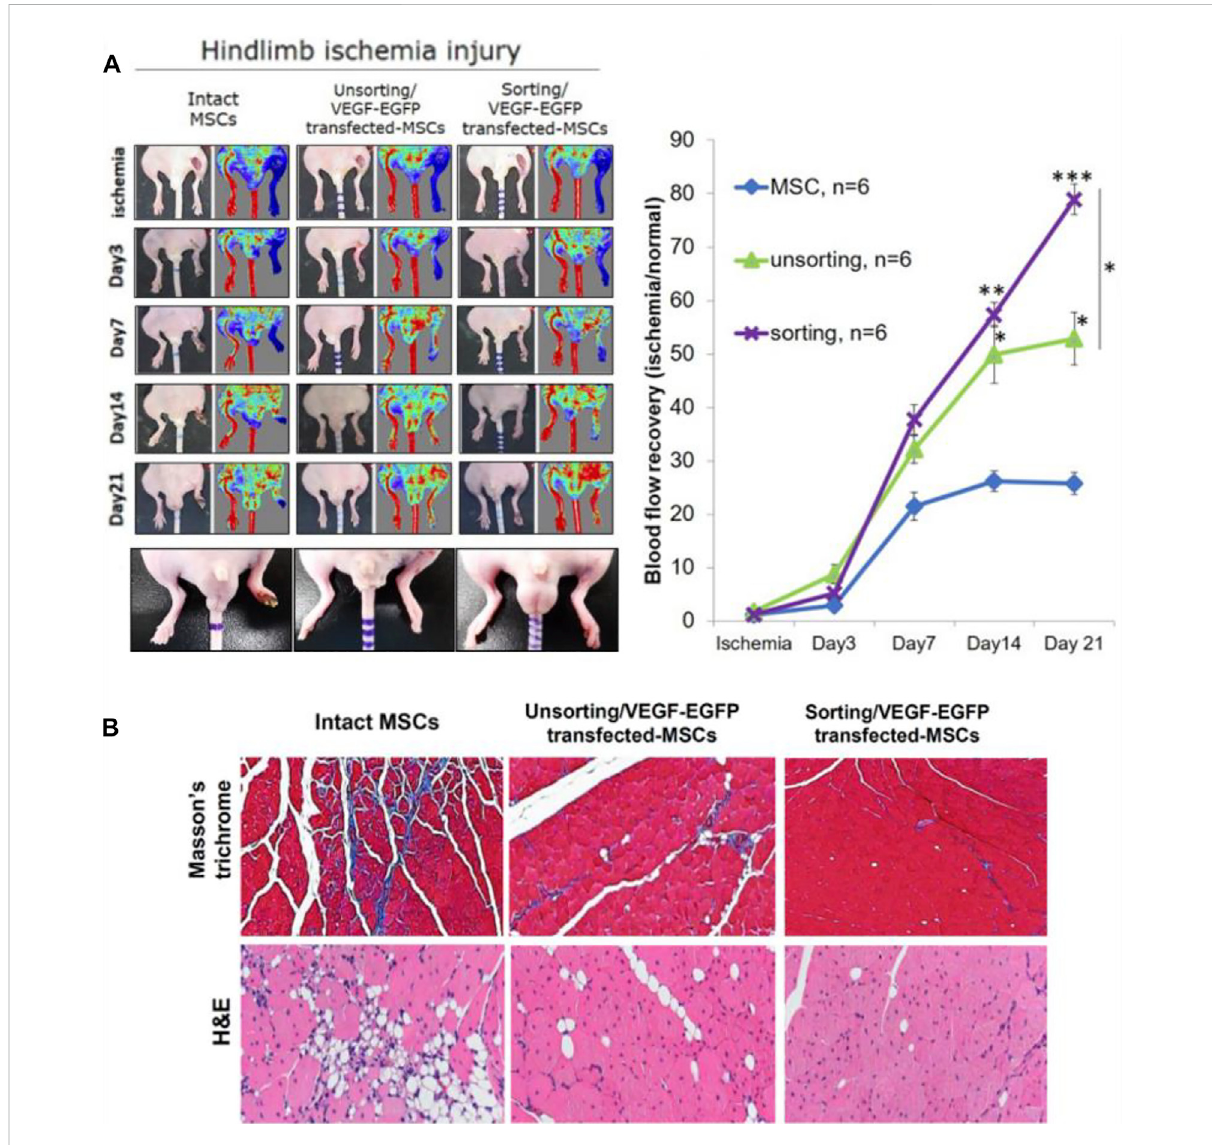
FIGURE 4 Schematic diagrams of MSCs transplantation to treat hind limbs ischemia in a mouse model. (A) LDPI images of ischemic hind limbs and analytical graphs of the perfusion recovery rate. (B) Representative pictures of Masson ’ s trichrome staining showing fi brosis and H&E staining showing necrosis. Figure adapted with permission from ref. (Park et al.,